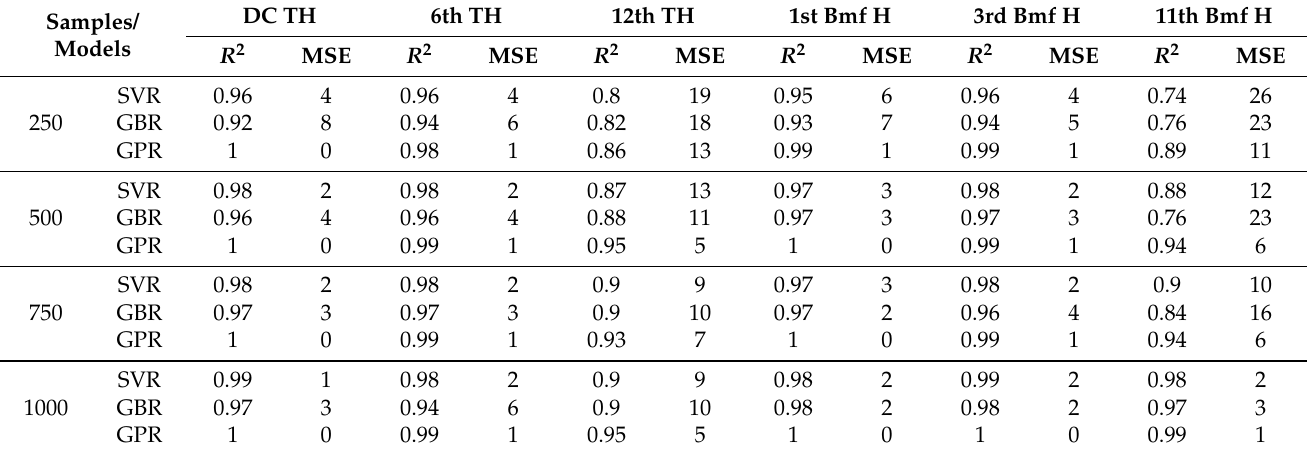
Table 4. Machine learning models performance to predict electromagnetic